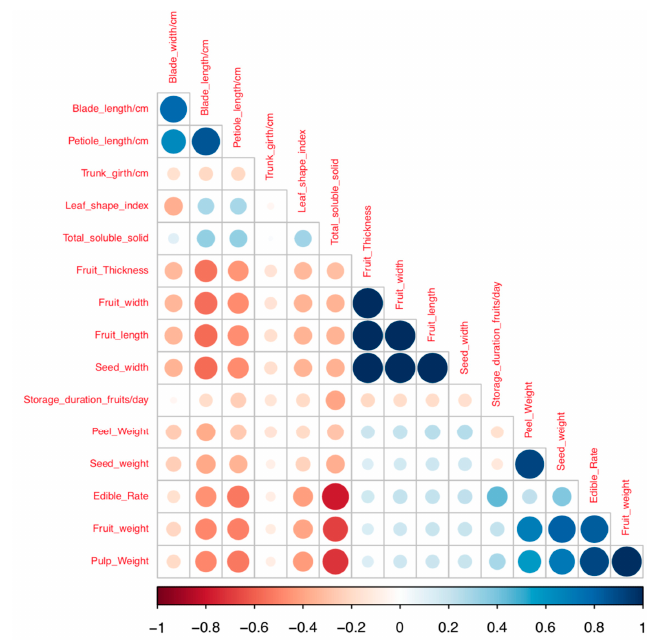
Figure 5. Correlogram for quantitative traits. Positive and negative correlations are displayed in blue and in red color, respectively. Correlation coefficients are proportional to color intensity, and the size of the circle is proportional to the correlation coefficients.